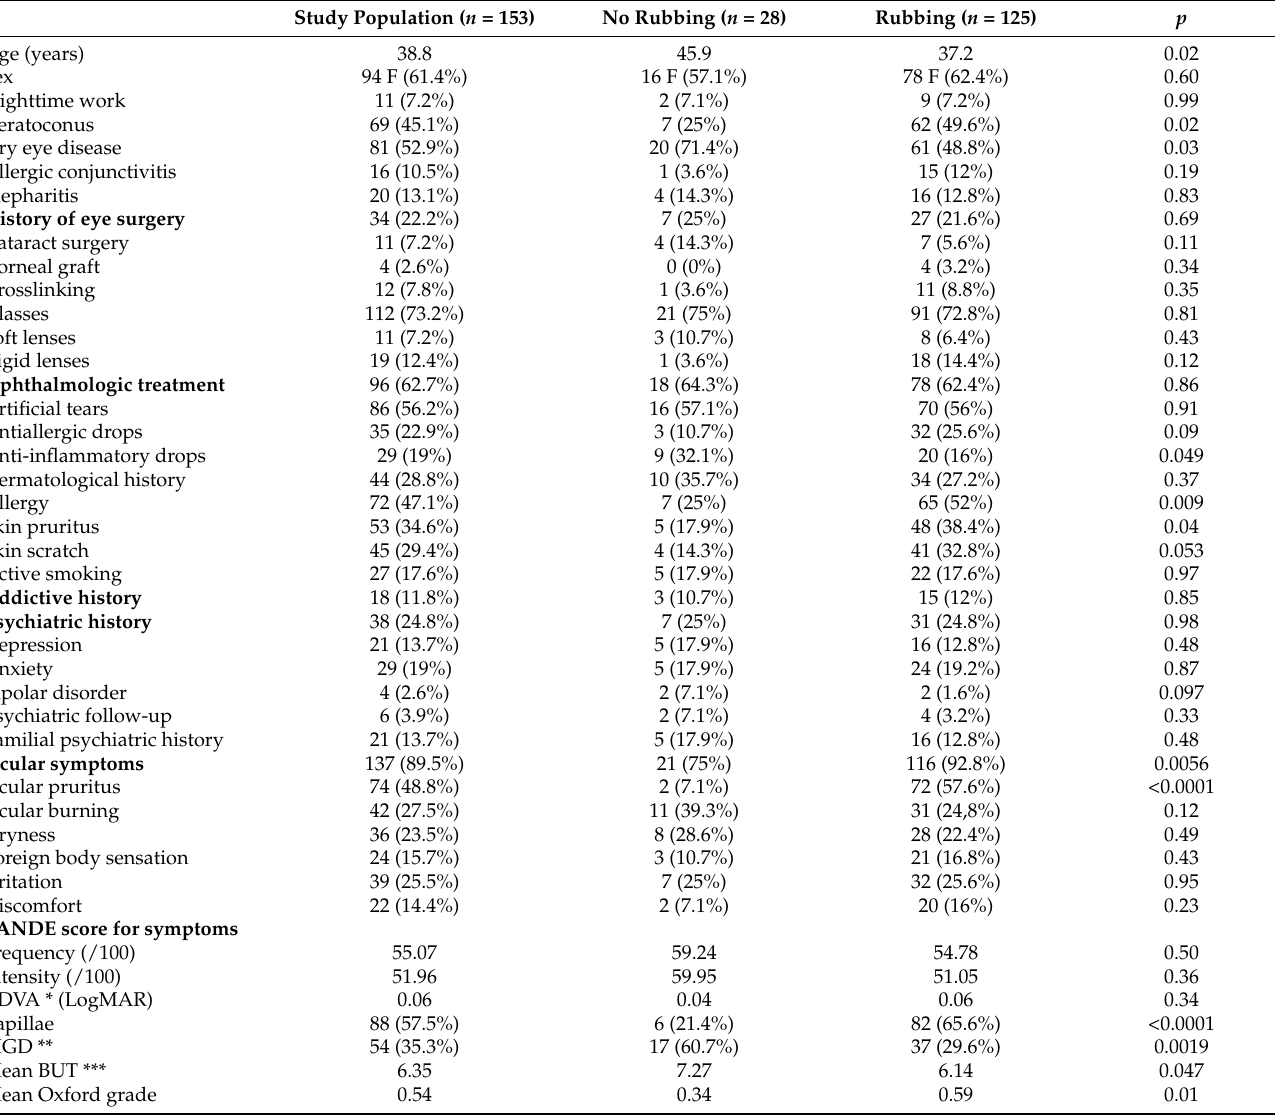
Table 2. Characteristics of the study population: No Rubbing (NR) and Rubbing (R)